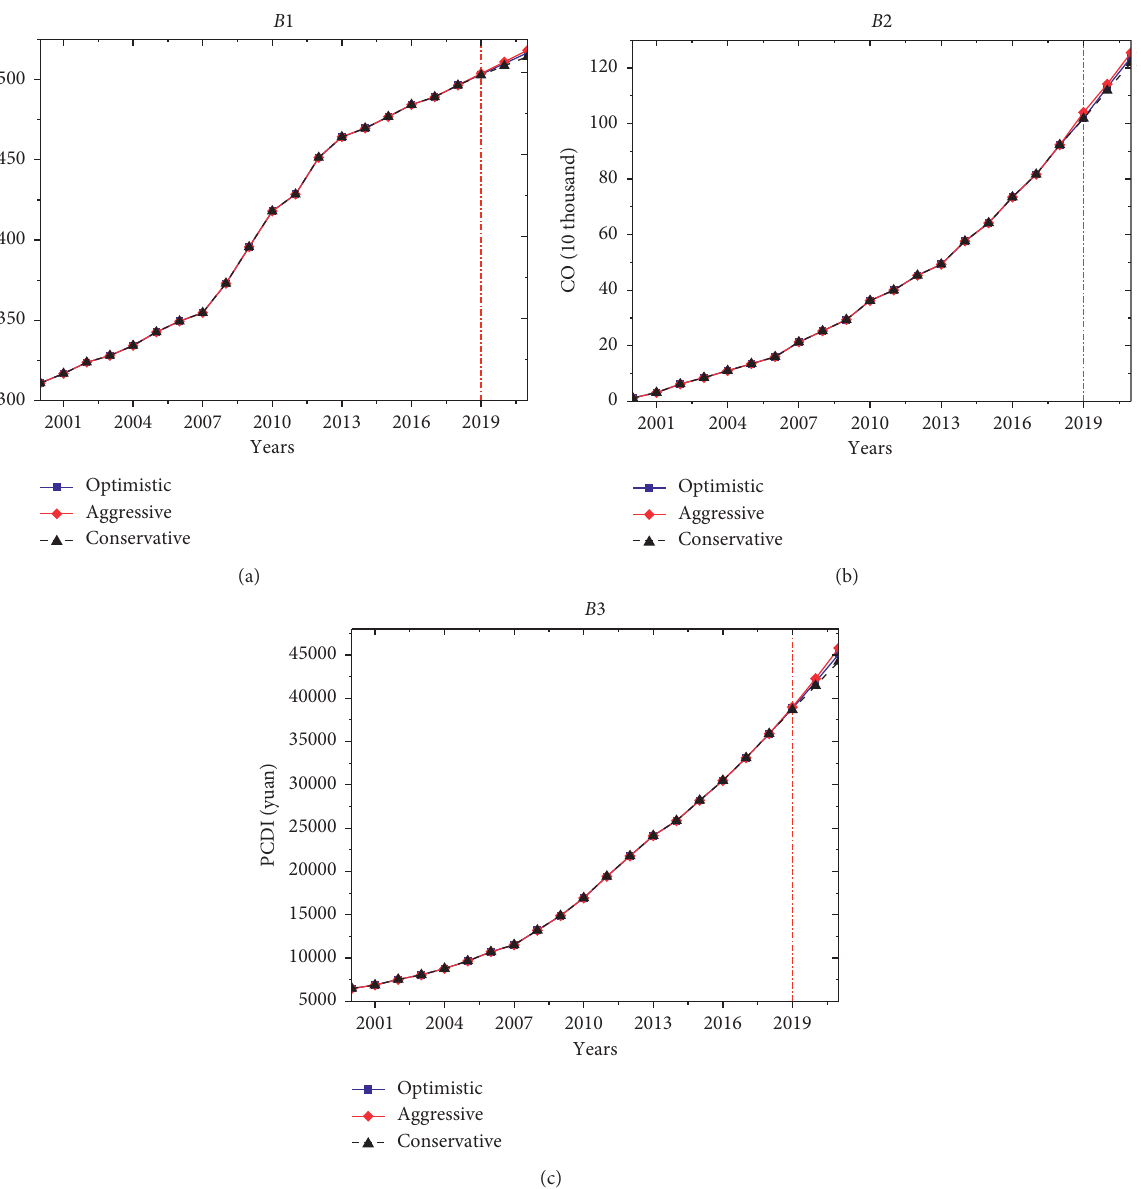
Figure 8: Future changes in the three data series for Yancheng (2019–2021): (a) future changes in UD, (b) future changes in CO, and (c) future changes in